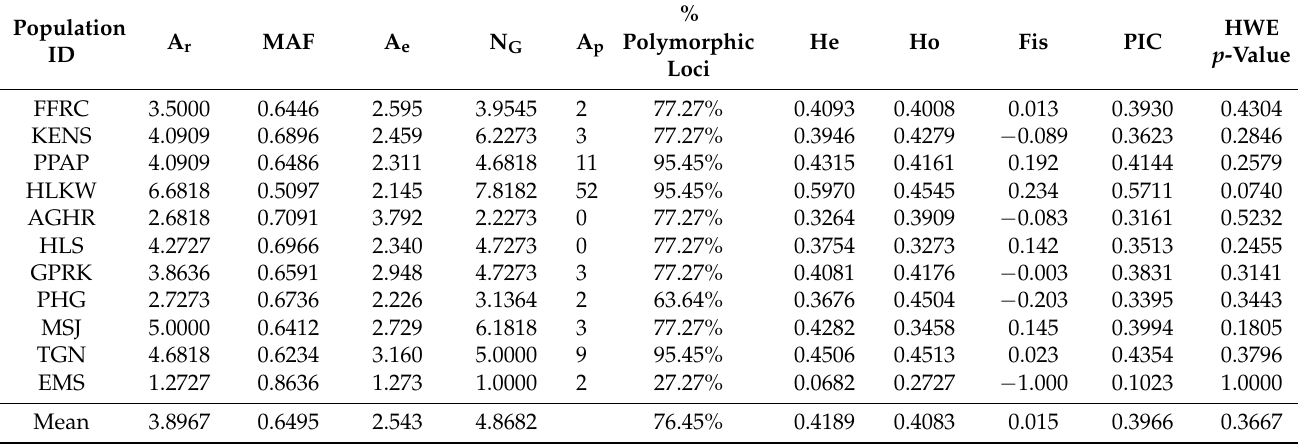
Table 2. Microsatellite diversity and polymorphism of Tor spp. stocks by